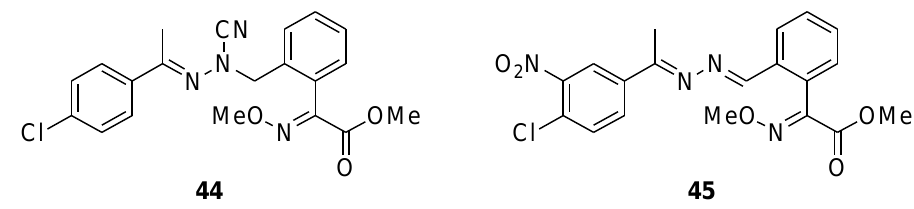
Figure 12. Structure of strobilurin analogs containing hydrazono-methyl moiety.